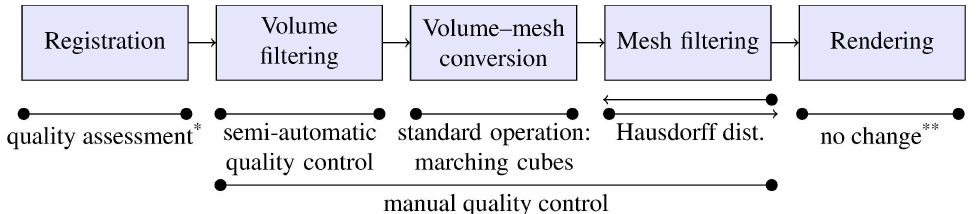
Fig 5. Pipeline of image processing and QC methods, both semi-automatic and manual. * The qualityof registrationis commented on in Lobachev et al. [25]. ** 3D renderingdoes not affect the data.